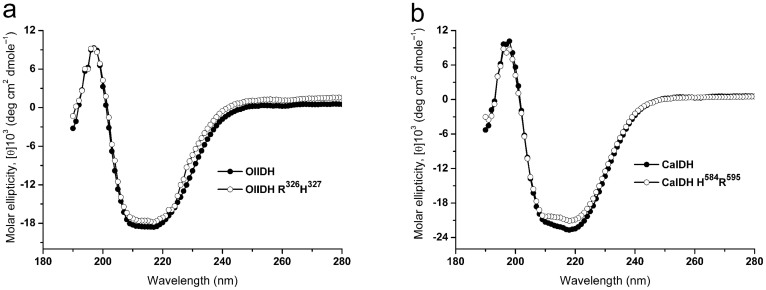
Circular diochroism (CD) spectra of the wild-type OlIDH, CaIDH and their mutants, OlIDH R326H327 and CaIDH H584R595.The CD was measured and the molar ellipticity was calculated as described in Methods section.